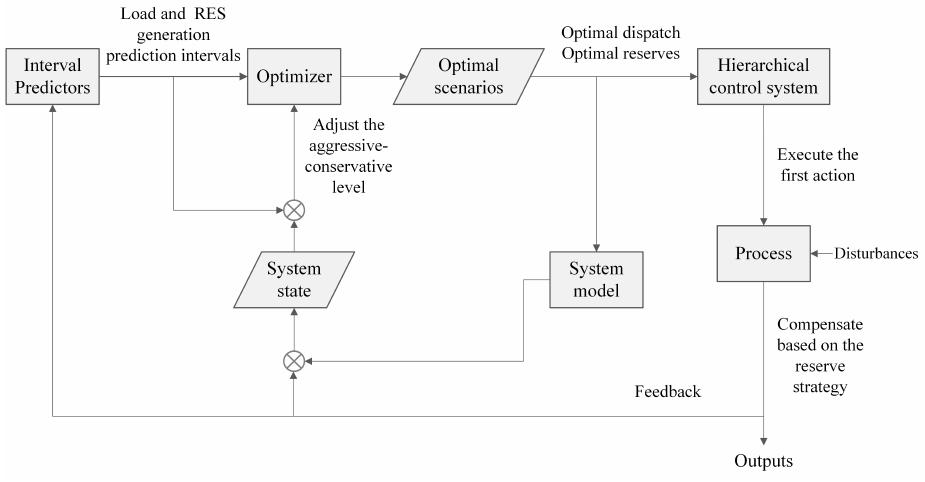
Figure 4. The flowchart of our method using the MPC approach as the